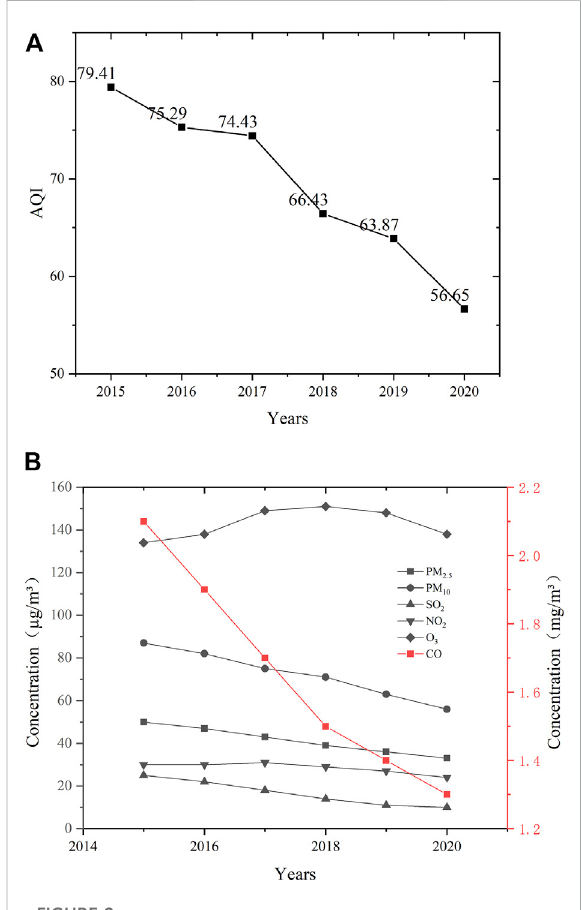
FIGURE 2 Annual variation of (A) air quality index (AQI) and (B) the concentrations of air